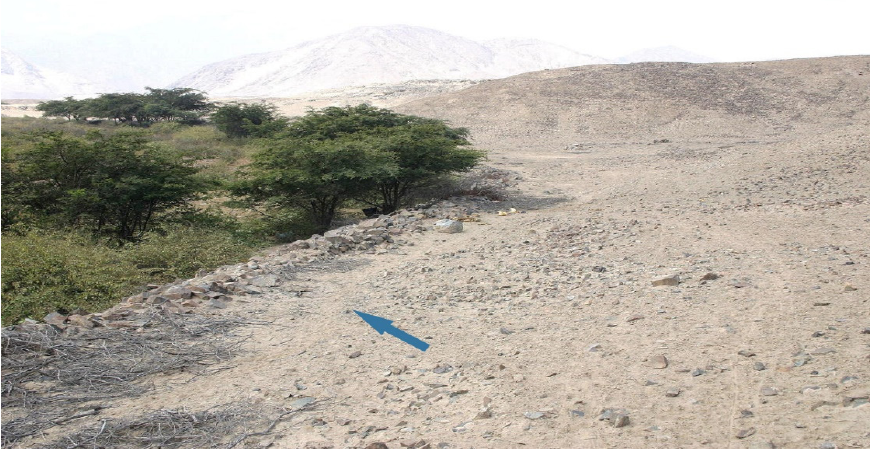
Figure 16. Trace of the canal leading to the Chupacigarro